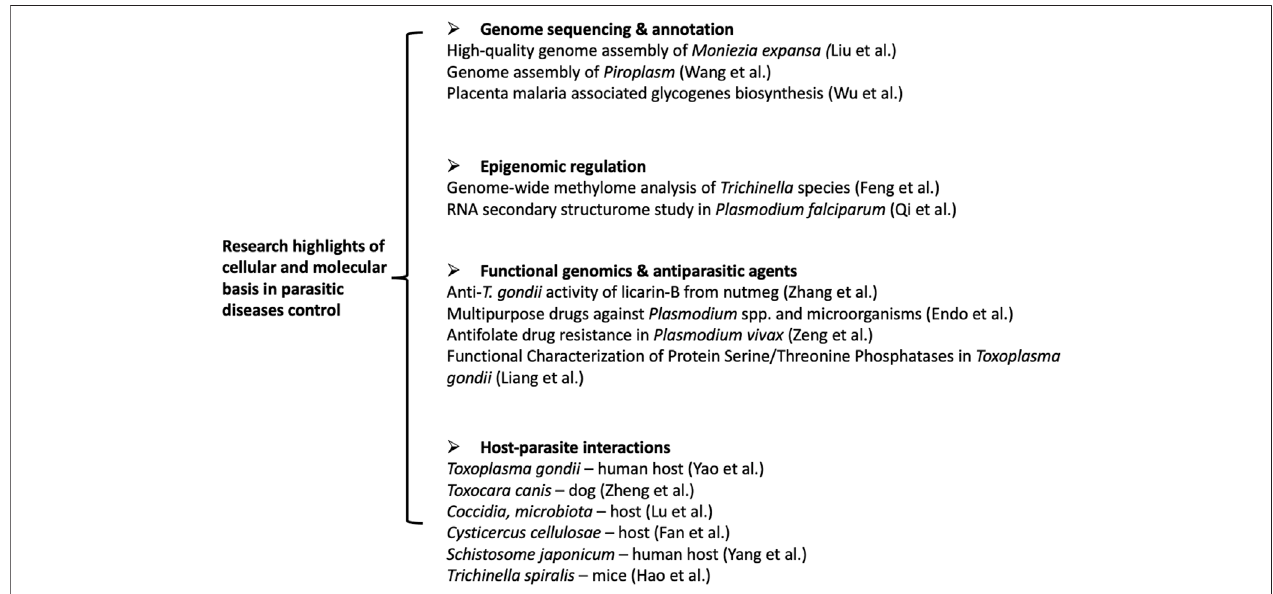
FIGURE 1 | Seleted articles in the research topic of the cellular and molecular basis in parasitic dieases control-research trends.